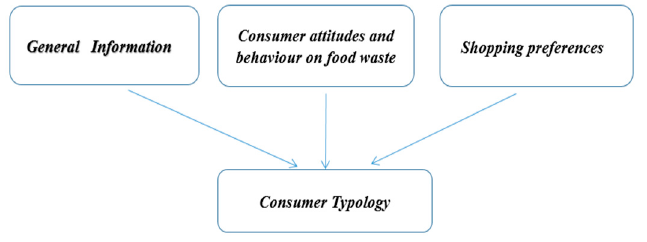
Figure 4. Questionnaire sections, own representation .